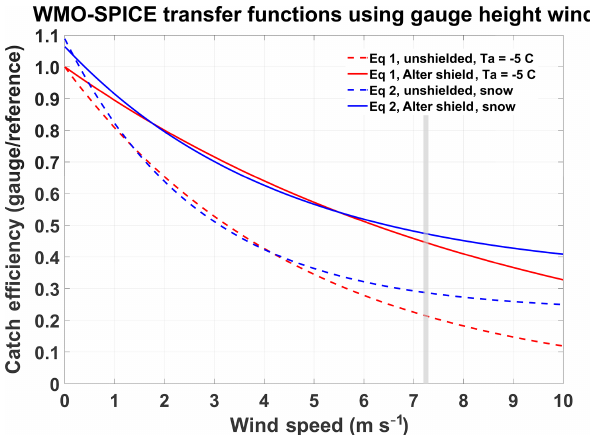
Figure 2. WMO-SPICE transfer functions from K2017b, Eq. (1; red), Eq. (2; blue) for unshielded (dashed), and single Alter-shielded (solid) gauges. Equation (1) is plotted using an air temperature of − 5 ◦ C, and Eq. (2) is plotted for snow. Both transfer functions are plotted for U gh , with the maximum wind speed threshold shown at 7.2ms − 1